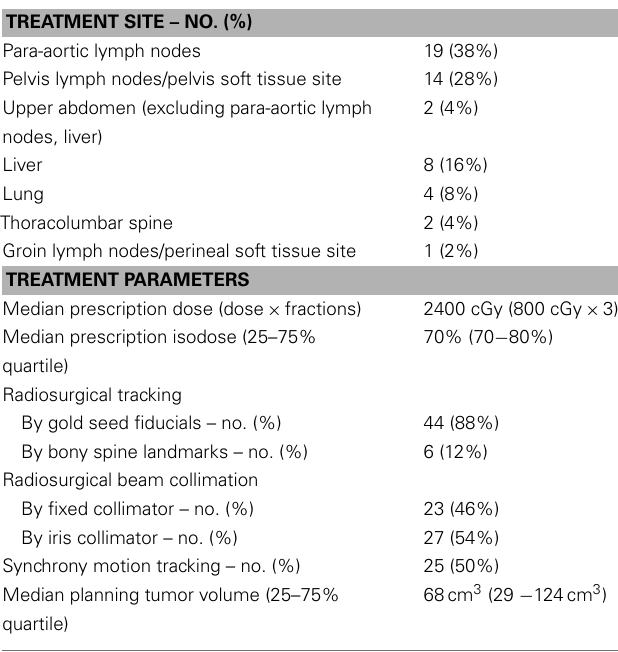
Table 2 | Stereotactic body radiosurgery sites of treatment and treatment